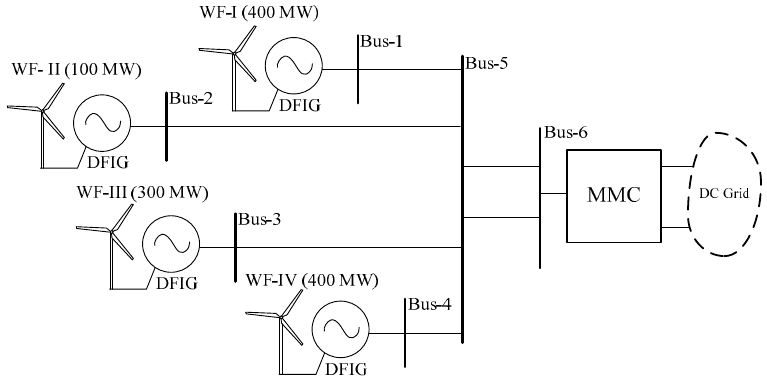
Figure 7. Wind farm integration with modular multilevel converter (MMC). Table 3. Line parameters 1 .